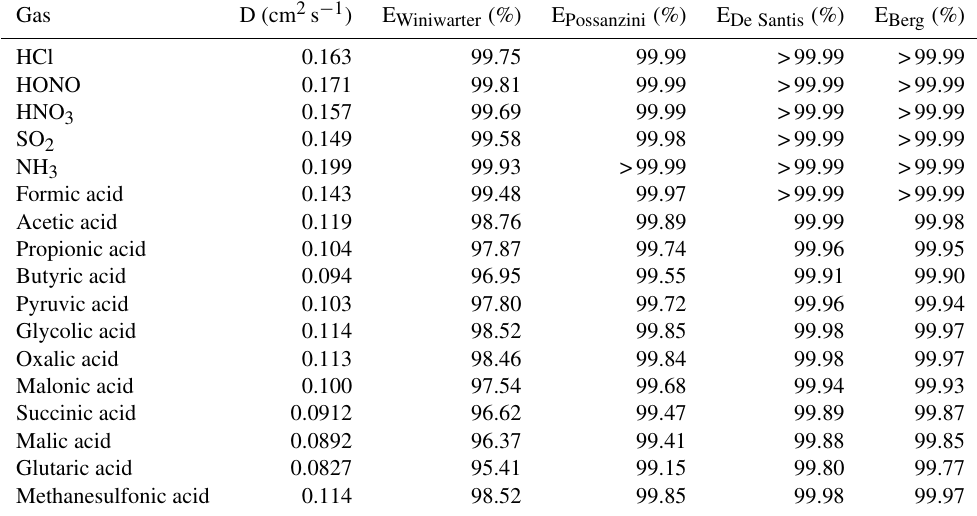
Table 4. Diffusion coefficients (D) calculated according to Fuller et al. (1966) and calculated annular denuder efficiencies (E) according to the equations of Winiwarter (1989), Possanzini et al. (1983), De Santis (1994) and Berg et al. (2010) for gases.